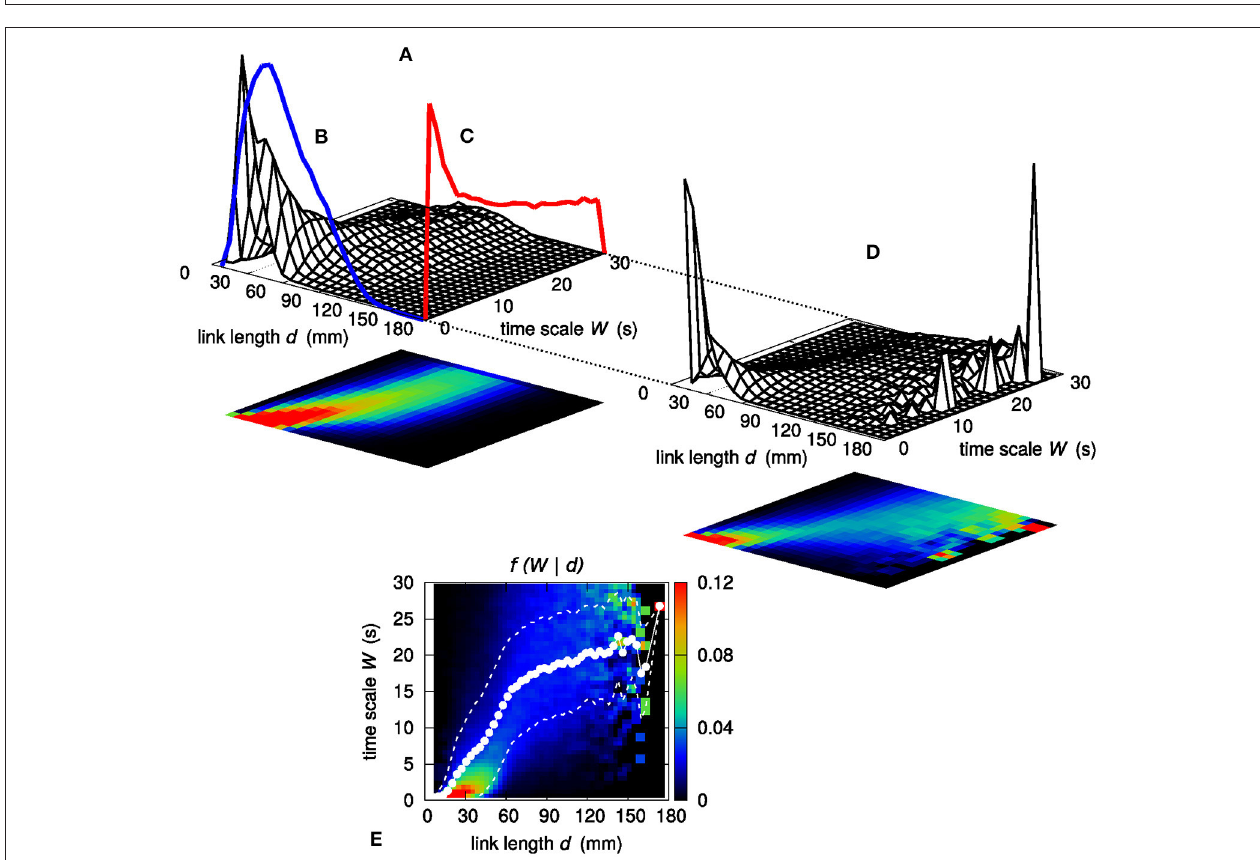
log[ W (s)], respectively. The comparison of the histograms shown in Figures 4 , 5 prompts us to set some constraints on the form of the mathematical expression of the relationship between W and d . First, no linear mapping of the abscissa axes can lead